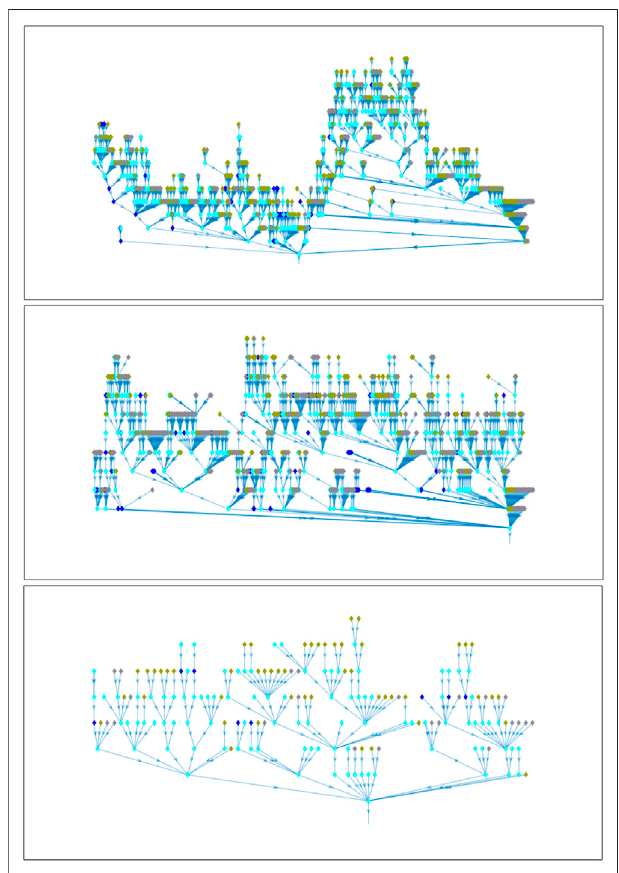
FIGURE 3 | The three largest subnetworks of the Hungarian surface water bodies and pollution sources. The nodes of the directed graphs are coloured according to the node-types. Cyan blue nodes represent the watercourses, the dark blue nodes denotes the standing water, nodes marked in green are the municipal wastewater treatment plants (WWTPs) and grey nodes are the industrial emission